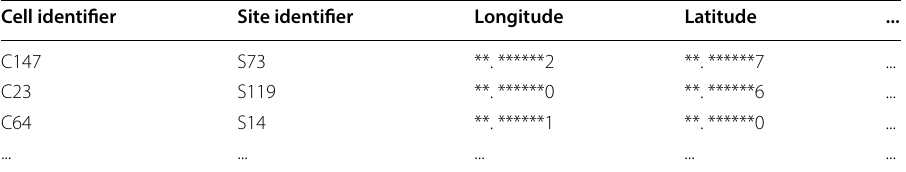
Table 1 Sample of cells and sites database